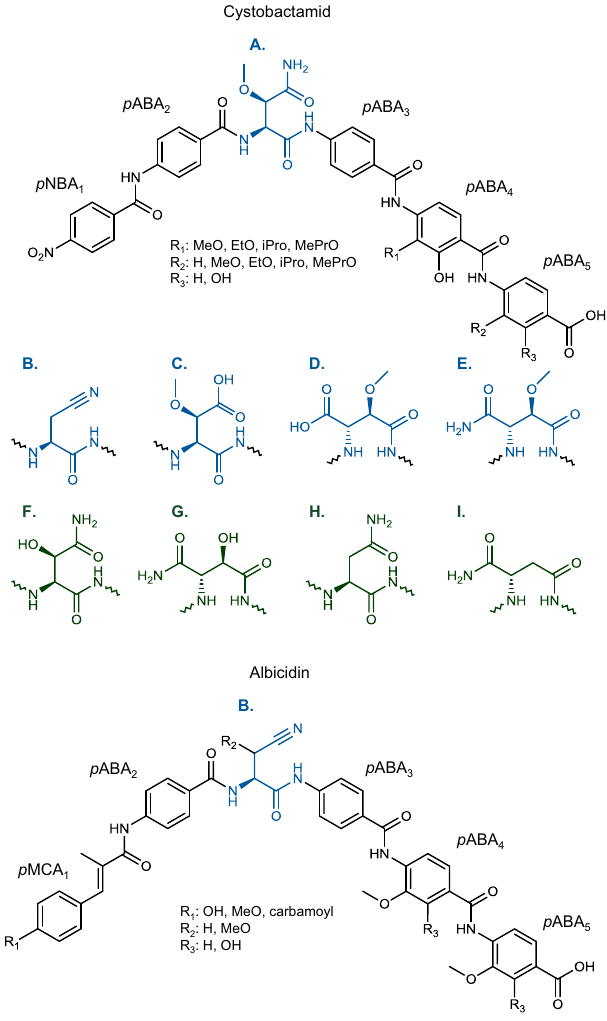
Fig. 1 Structural variations among native and unnatural cystobactamids and structure comparison with albicidin. para -Nitrobenzoic acid ( p NBA) and para -aminobenzoic acid ( p ABA) with possible substitutions ( R 1 , R 2 , R 3 ) are shown in black. Different linker moieties of natural cystobactamids (shown in blue; linker ( A ) – ( E )) and unnatural cystobactamids (shown in green; linker ( F ) – ( I ); Table 1): ( A ) β -methoxy- L -asparagine, ( B ) β -cyano- L - alanine, ( C ) β -methoxy- L -aspartate, ( D ) α -methoxy- L -isoaspartate, ( E ) α - methoxy- L -isoasparagine, ( F ) β -hydroxy- L -asparagine, ( G ) α -hydroxy- L - isoasparagine, ( H ) L -asparagine, ( I ) L -isoasparagine. The scheme was adapted from Hüttel et al. 2 . The stereochemistry of the linker moiety is based on the assignment by Planke et al. 44 . Albicidin carries an N-terminal para -methylcoumaric acid ( p MCA p ABAs, two substituted p ABAs, 1 ), two and a (possibly modi fi ed) β -cyano- L -alanine ( B ) or β -methoxy- L -asparagine ( A ) linker. Different possible substitutions ( R 1 , R 2 , R 3 ) are